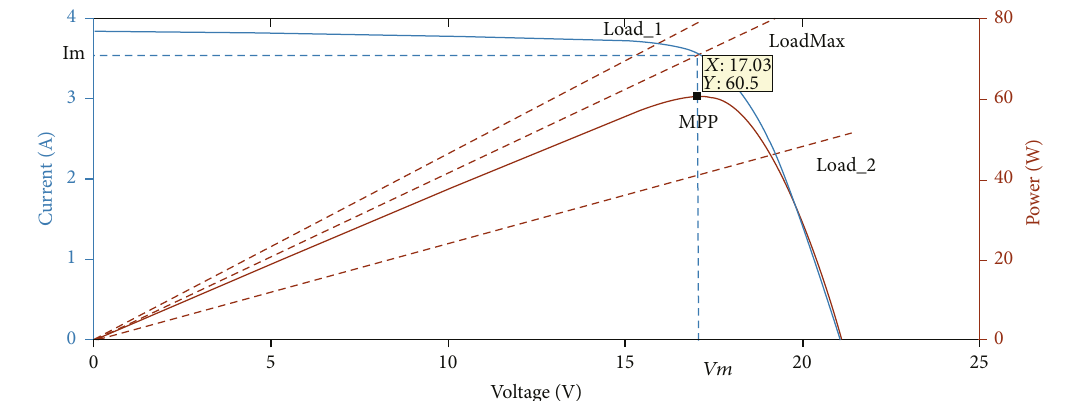
Figure 15: The impact of load on I ‐ V and P ‐ V characteristics.